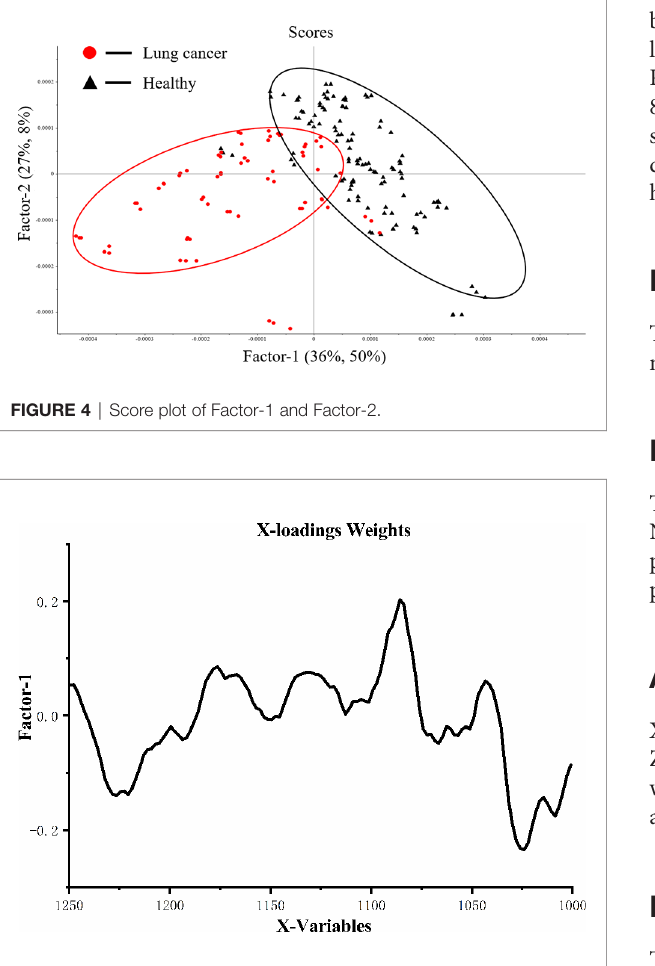
people. The results of spectral band area comparison showed that the concentrations of protein, lipid and nucleic acids molecules in serum of patients with lung cancer were increased compared with those in healthy people. PCR and PLS-DA were performed on the spectral data after different preprocessing. PLS-DA model